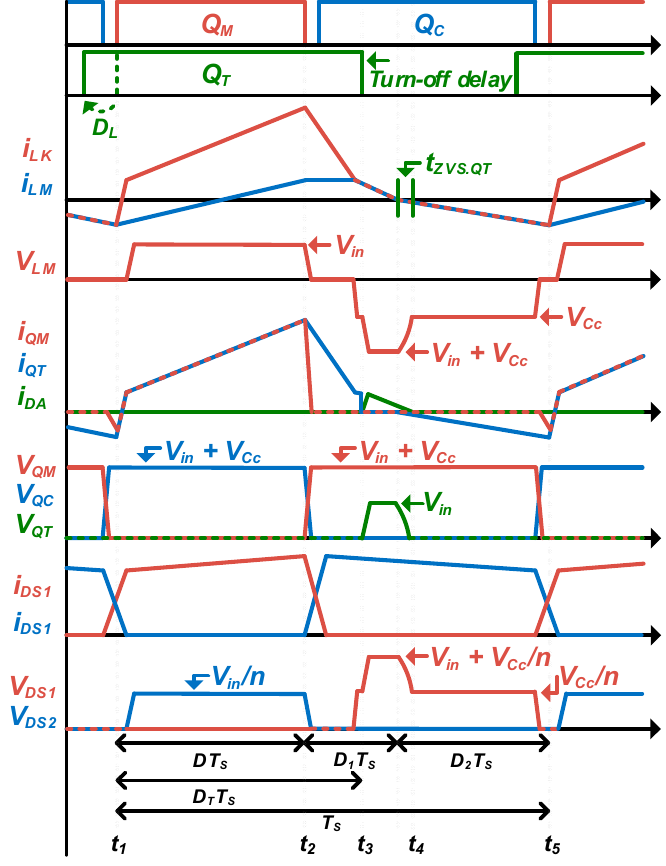
Figure 7. Key waveforms of the proposed converter.